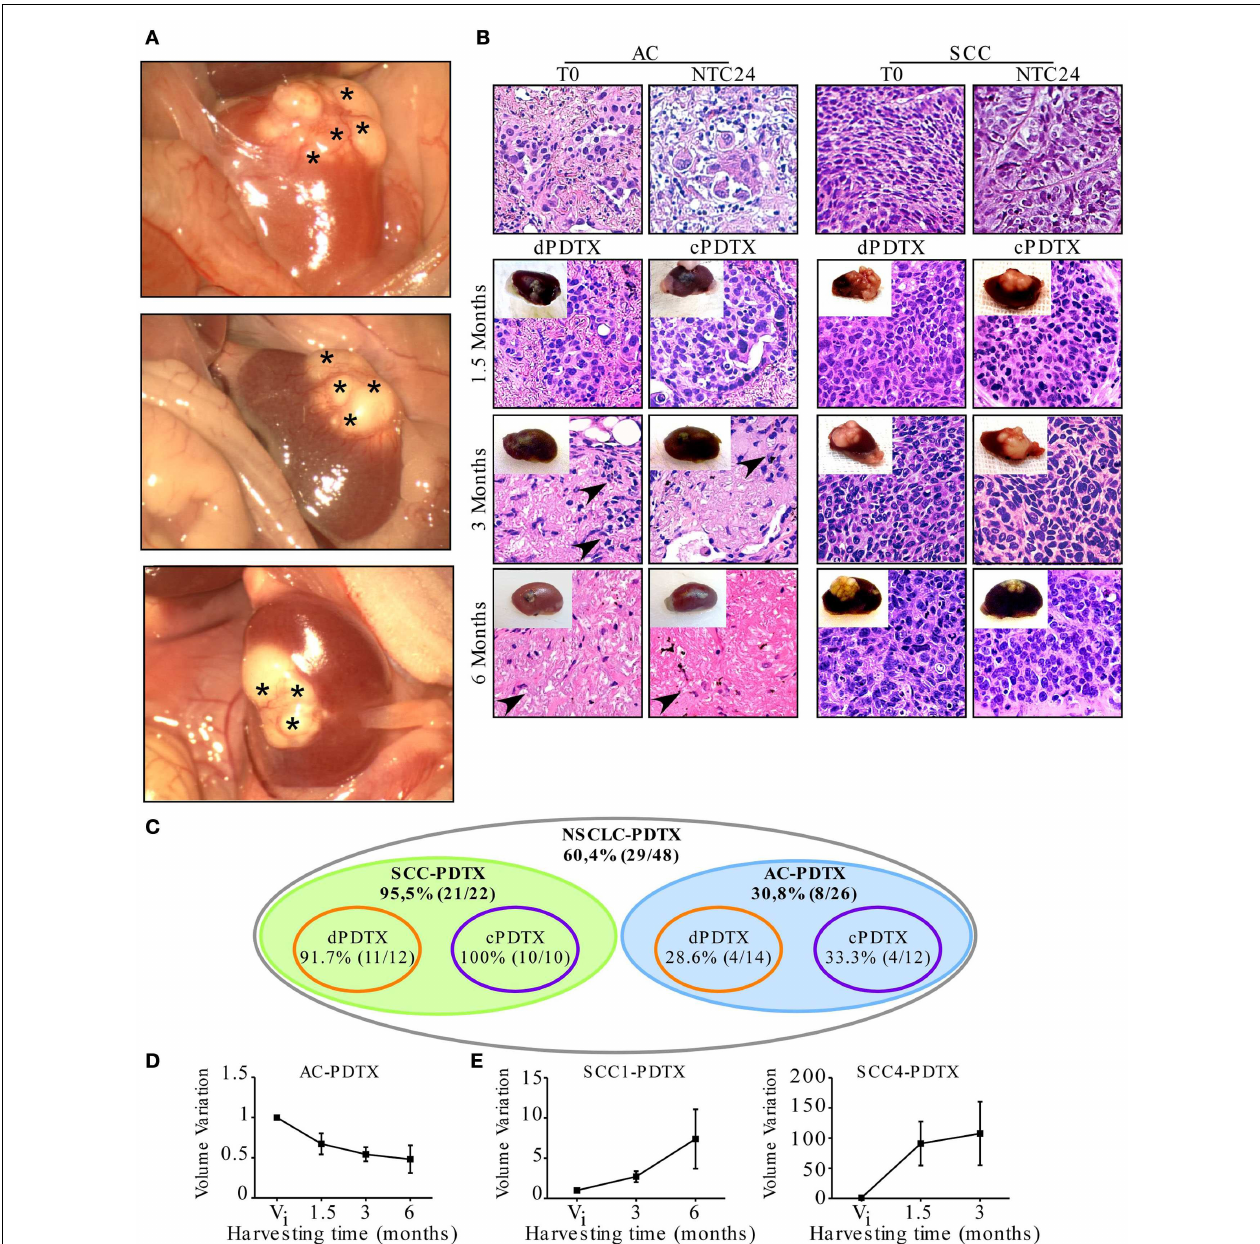
1.5months from the graft.The absence of epithelial cancer cells is evident in AC-PTDTXs harvested at 3 and 6months. Black arrow heads indicate stromal cells. Original magnification is 200 × . (C) Schematic representation of PDTXs engraftment rates. (D,E) Quantification of AC (average of AC2, 3, and 5 samples); (D) SCC1 and SCC4-PDTXs. (E) Volume variation compared to initial tumor volume ( V i ) at different time points, respectively. For all experiments, bars represent mean ±